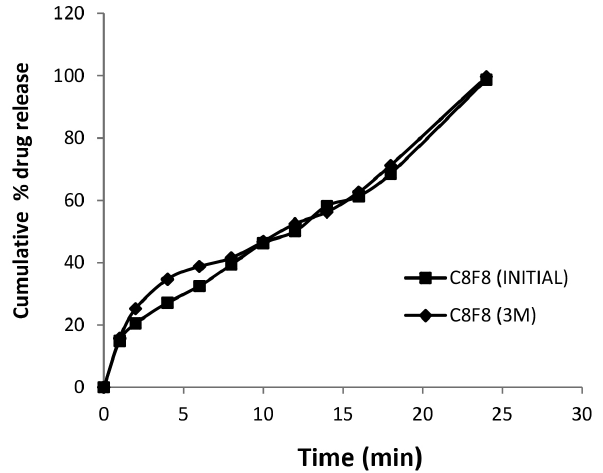
FIGURE 7 - In vitro drug release study of ofloxacin from bilayer tablets before and after 3 months.